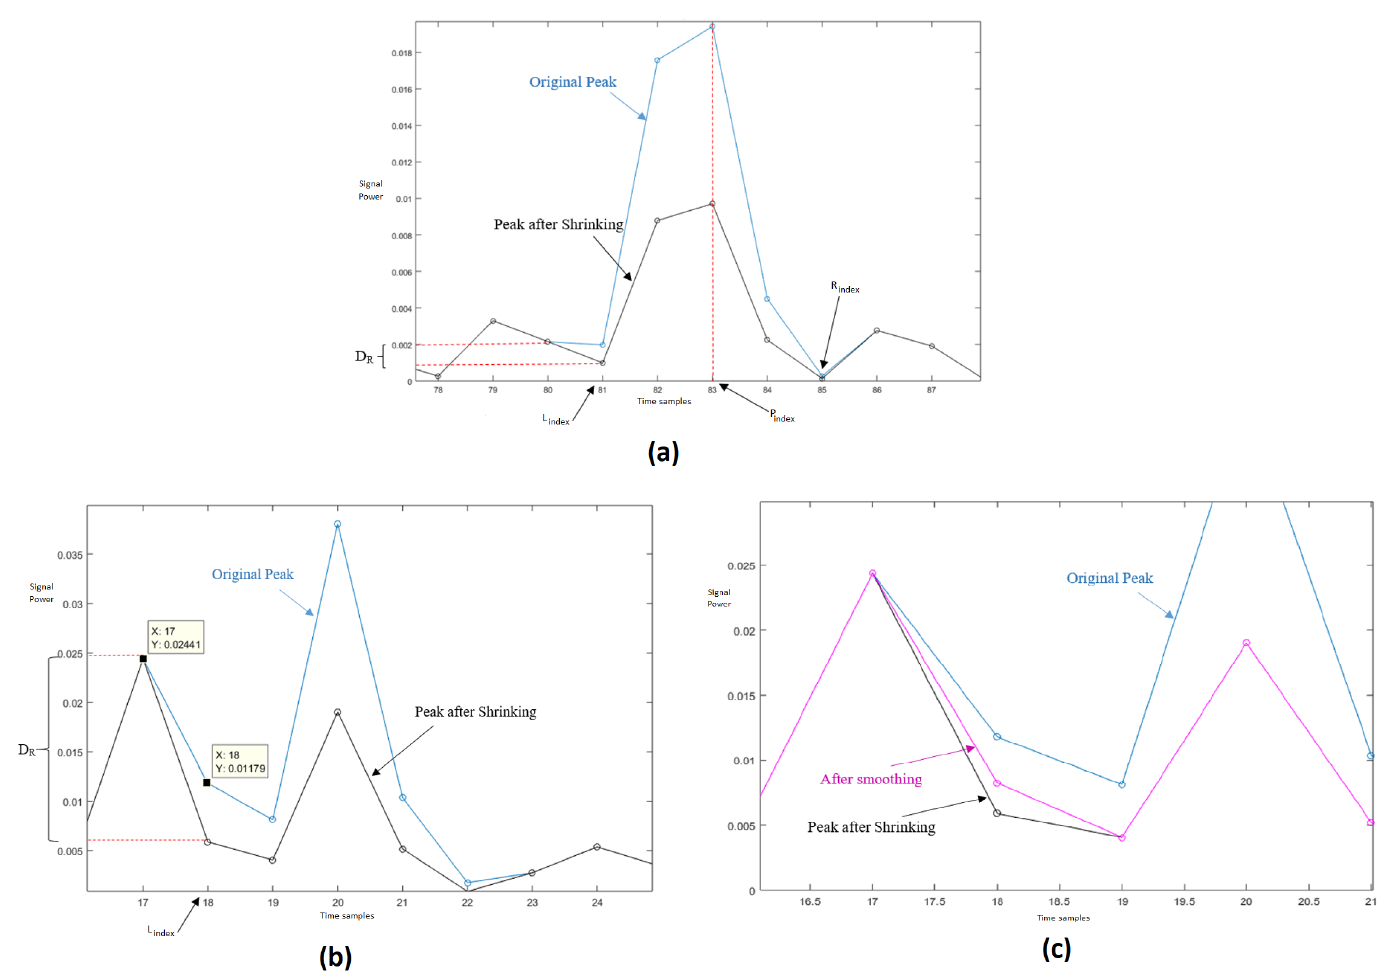
Figure 7. ( a ) An example of a peak border does not need matching/smoothing; ( b ) an example of a peak border that needs matching/smoothing; ( c ) an example of a peak border after the matching/smoothing process